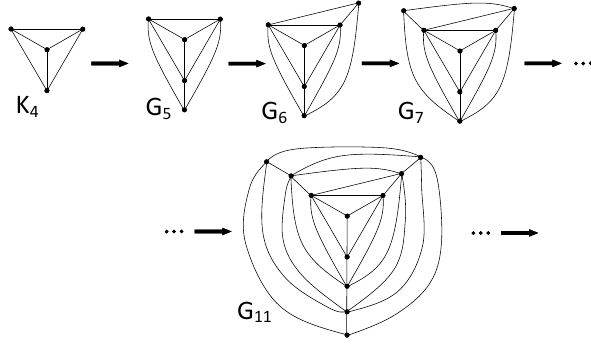
Fig. 12: Constructing a planar LH graph with maximum vertex degree 6.